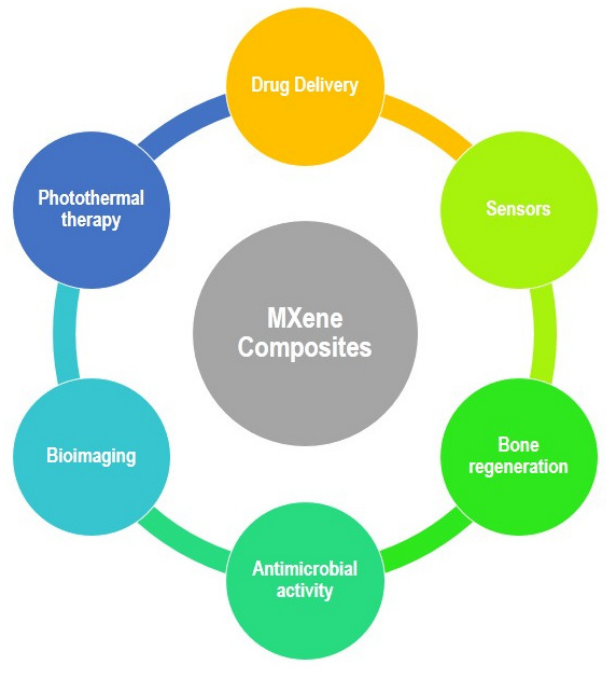
Figure 7. Schematic representation of assorted applications of MXene composites.